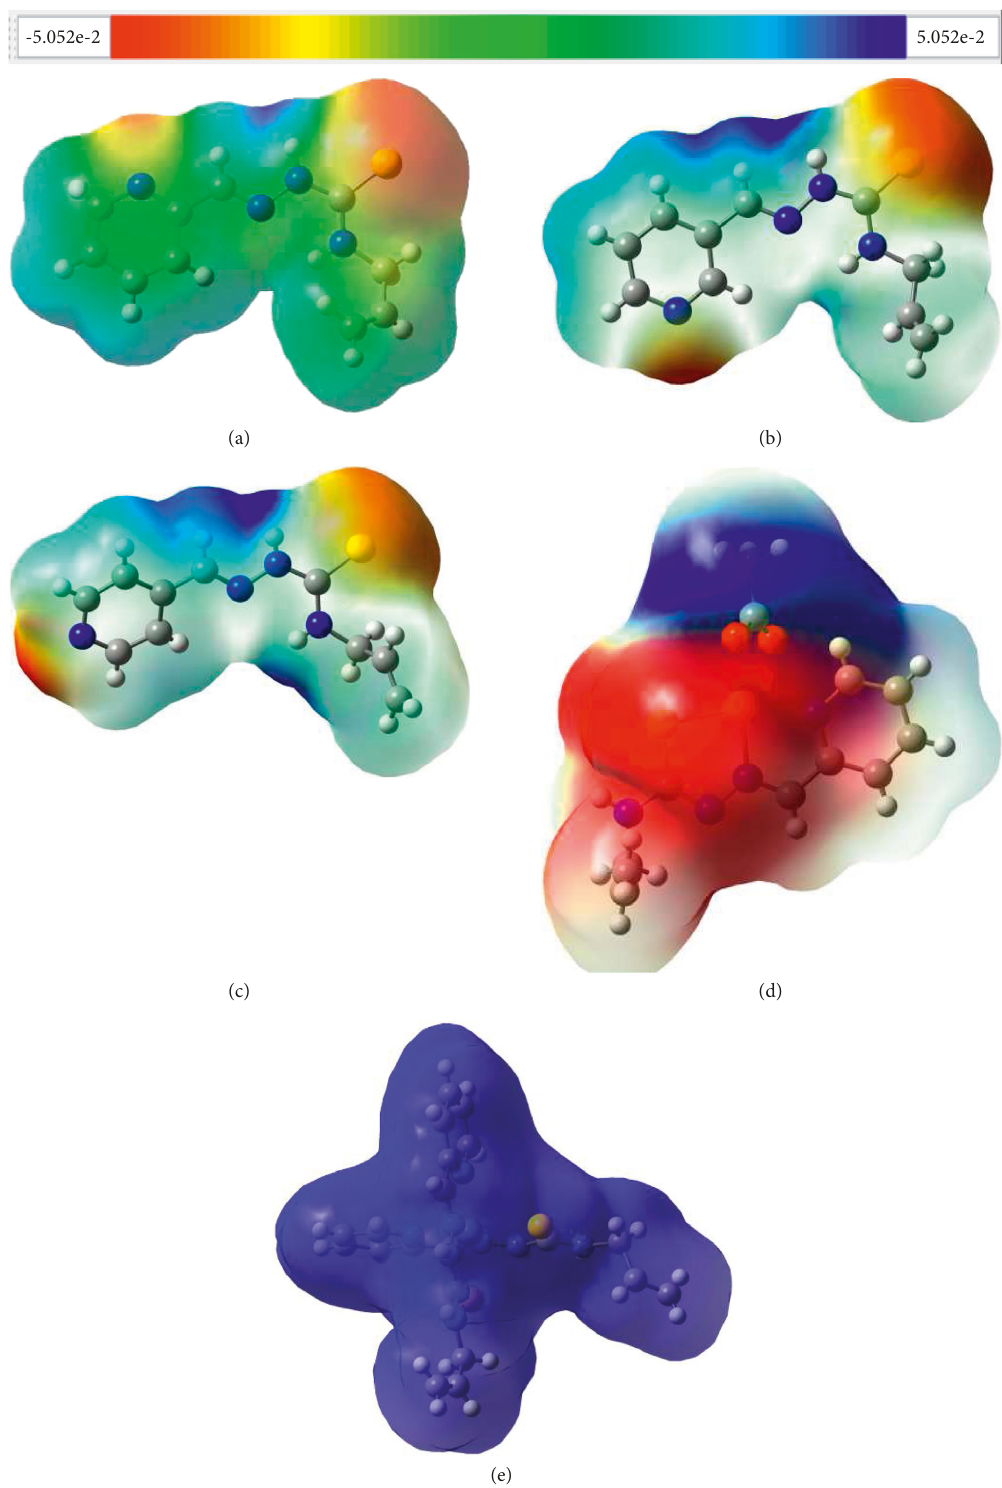
Figure 4: Electrostatic potentials mapped on the molecular surfaces of (a) HL , (b) HL a , (c) HL b , (d) 4 , and (e) 5 . The values of MEPs range from − 31.7 to